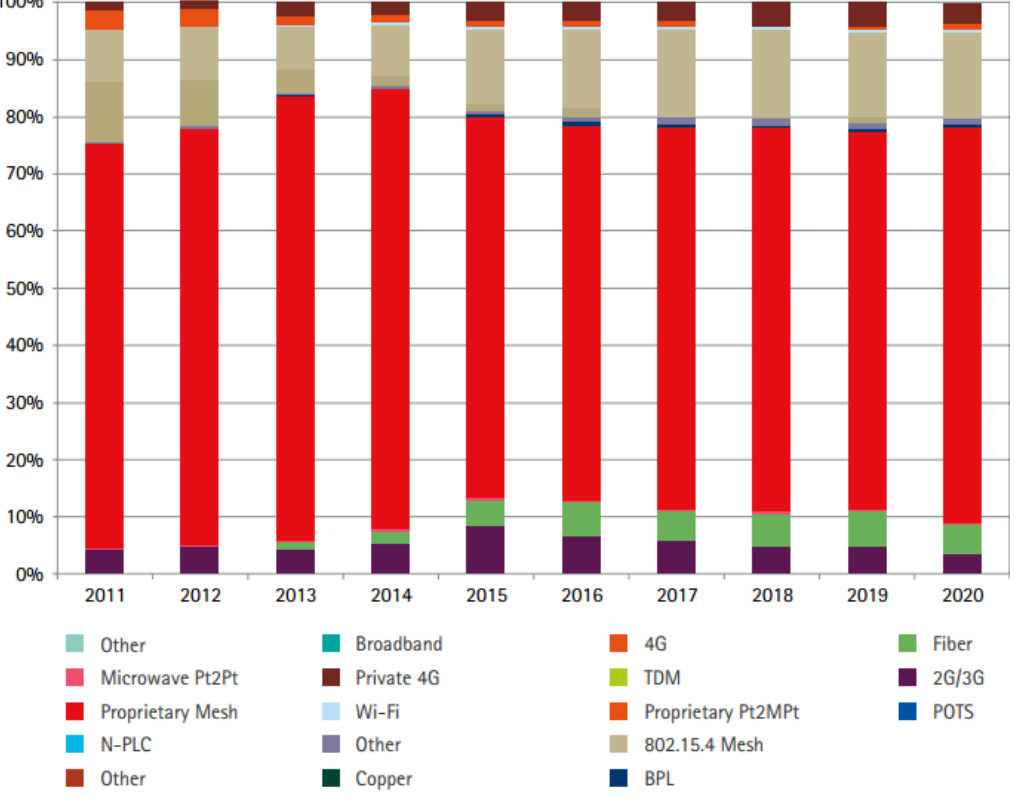
Figure 2. Communications node segmentation by technology, world markets, 2011–2020 (Source: Navigant Research [27]). Reprinted with the permission of Navigant Research, “Smart Grid Networking and Communications”, published by Navigant Research, 2012.